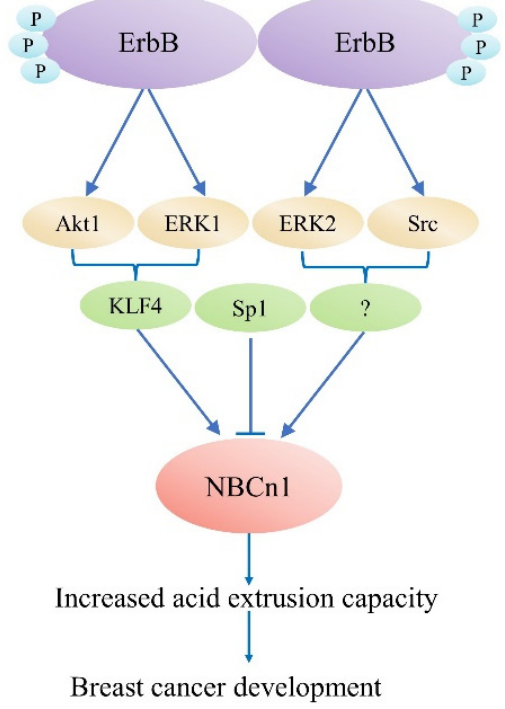
Figure 4. ErbB2-dependent SLC4A7 expression regulation model. The truncated ErbB2 receptor is responsible for regulating SLC4A7 expression.